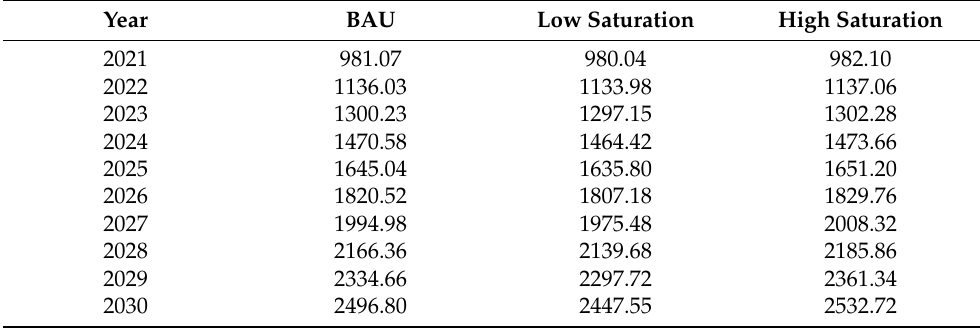
Table 2. Estimation of total recyclable plastics from EoL passenger vehicles from 2021 to 2030 (thousand